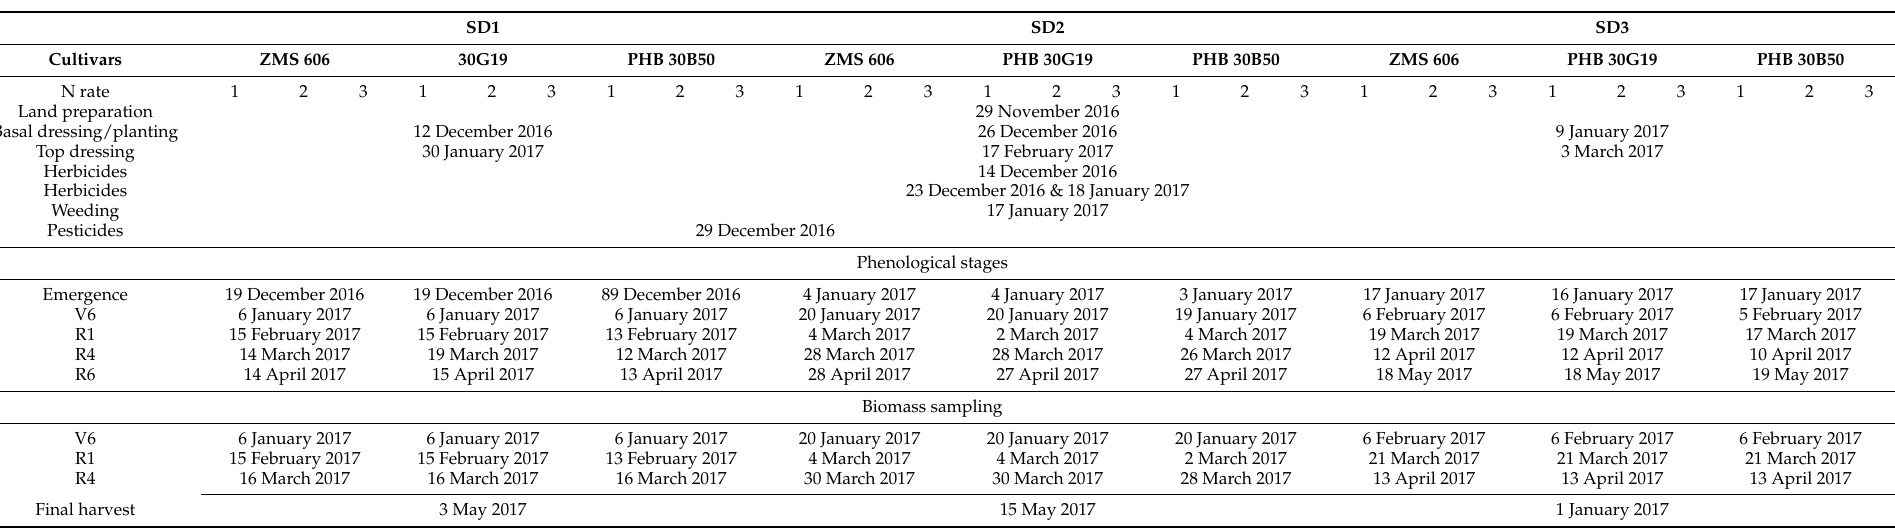
Table A1. Summary of the observed data collected from the rainfed experiment site. Reproduced with permission from [33].